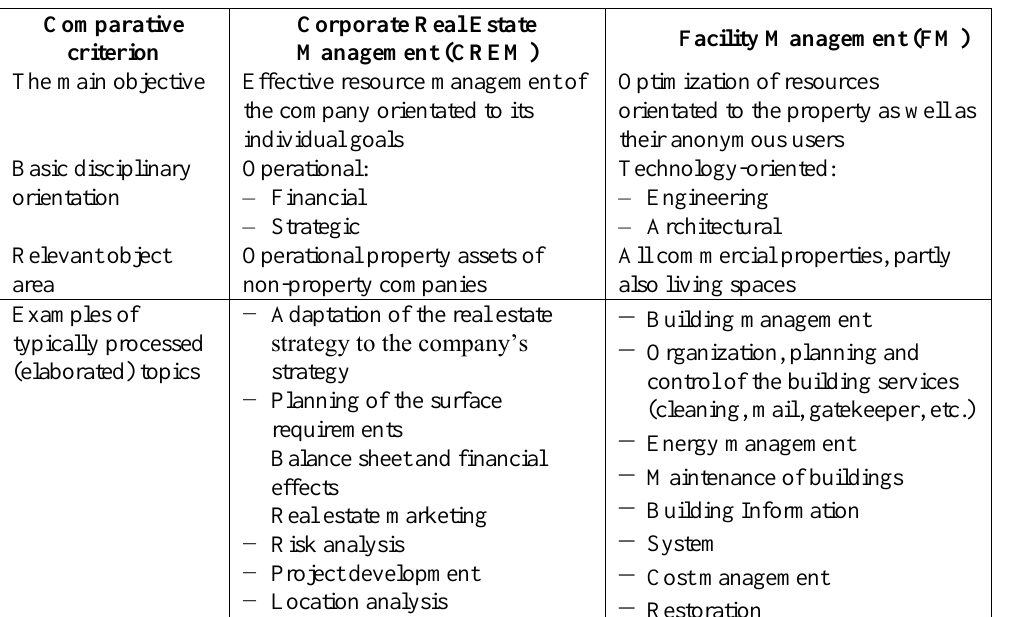
Table 3 . Comparison of CREM and FM (Pfnür, 2002, p.